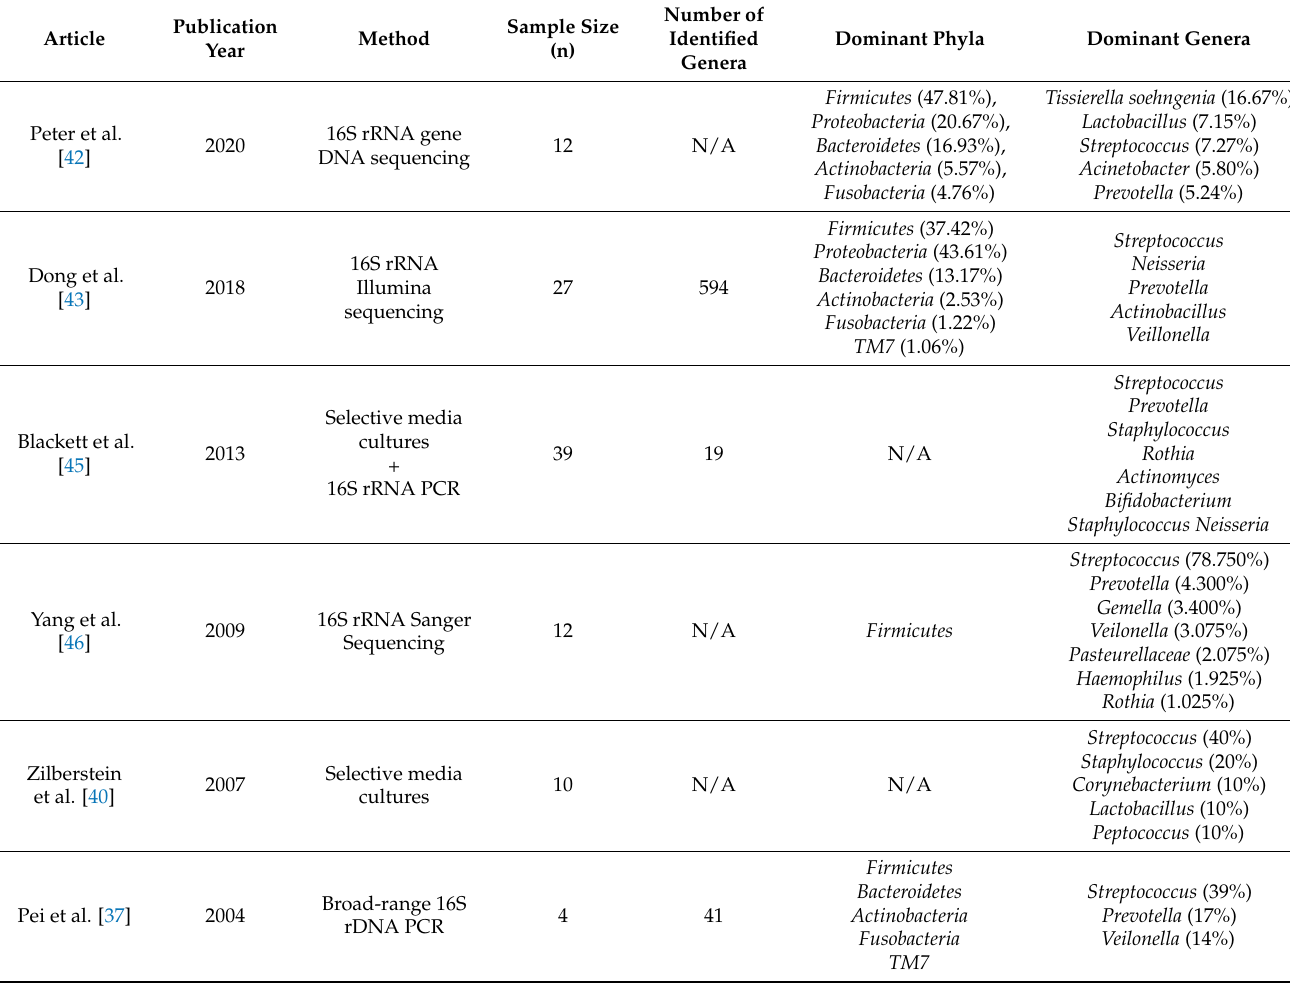
Table 1. Microbiota expressed by normal